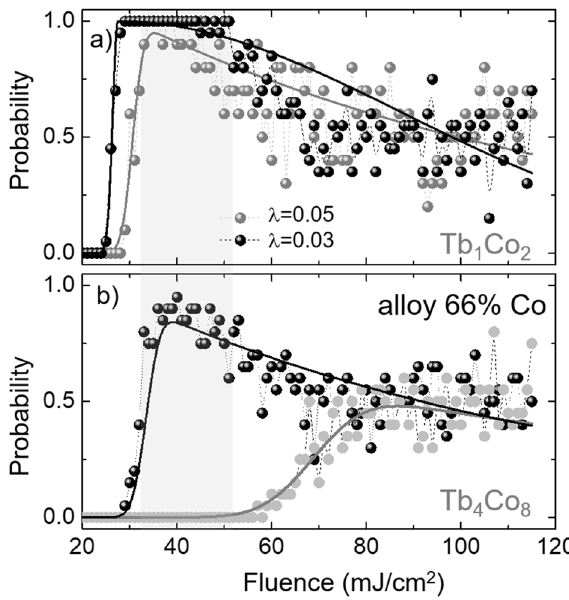
Figure 4. ( a ) Switching probability as a function of the laser fluence for the system [ Tb 1 / Co 2 ] over 20 events with two different values of damping constant (cid:31) = 0.03 and 0.05. There is a maximum of the switching probability for F = 35 mJ/ cm 2 for the case of (cid:31) = 0.05. ( b ) Switching probability as a function of the laser fluence for the system [ Tb 4 / Co 8 ] and for a homogeneous TbCo alloy with 66% of Co. Black and grey solid lines are a guide to the